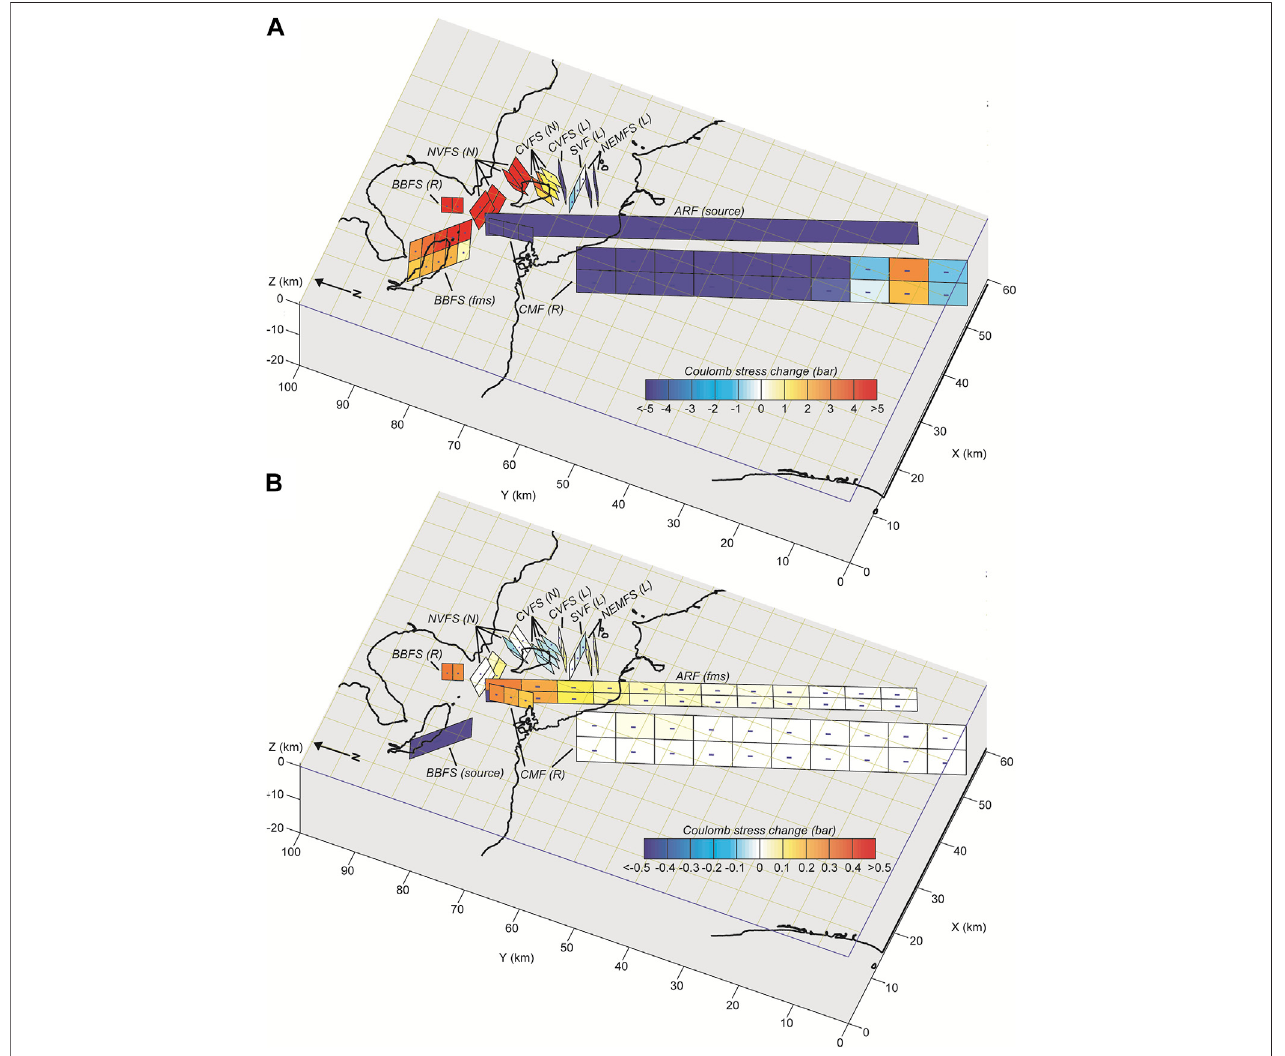
FIGURE11| CalculatedCoulombstresschangesat μ ’ =0.4onreceiverfaultsinoffshoresouthernBatangasduringthe (A) 1994Mw7.1earthquakeand (B) 2017 Mw 5.9 earthquake. Hotter colors indicate stress increase. ARF, Aglubang River Fault; CMF, Central Mindoro Fault; NVFS, North Verde Fault System; CVFS, Central Verde Fault System; SVF, South Verde Fault; NEMFS: Northeast Mindoro Fault System; BBFS, Batangas Bay Fault System. The letters in parenthesis indicate the fault geometry.R,pureright-lateralfault(dip/rake: 90 ° /180 ° );L,pureleft-lateralfault(dip/rake:90 ° /0 ° );N:purenormalfault(dip/rake:60 ° / − 90 ° );fms:derivedfrom GCMT focal mechanism solution (ARF strike/dip/rake: 339 ° /70 ° /-178 ° ; BBFS strike/dip/rake: 314 ° /85 ° /176 ° ). The shorter fault models have downdip widths of 5 km while the longerfaultshavedowndipwidthsof15 km.Faultplanesaredividedbasedontheirlengthandwidthtoobservevariationsinstressreceived.Faultparametersarefound in the Supplementary